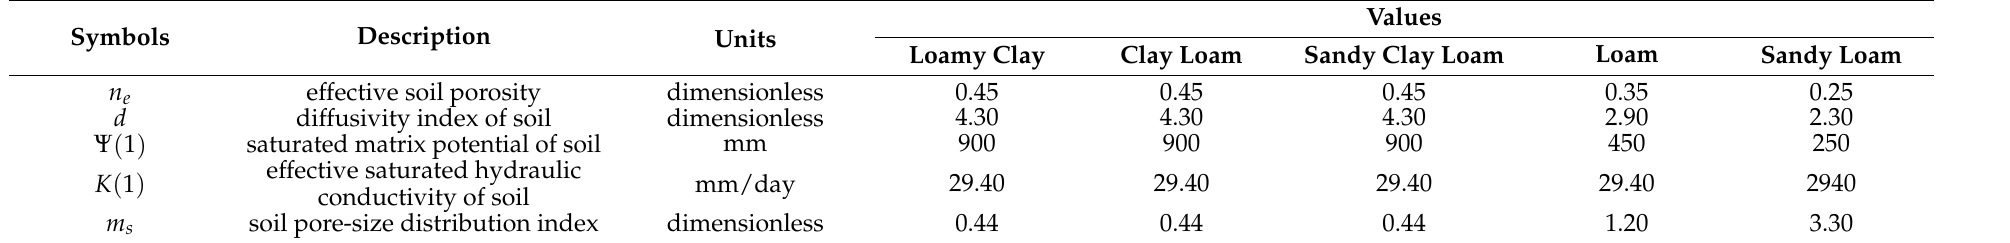
Table 2. The empirical values of the soil parameters of five soil texture